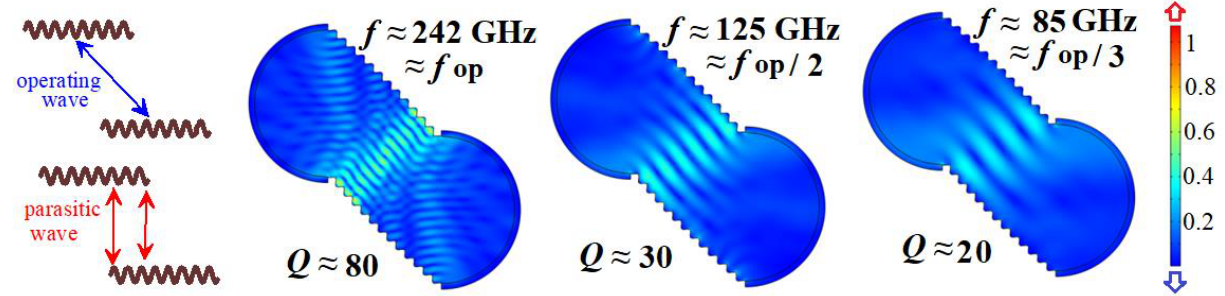
Figure 3. Modes corresponding to ordinary Fabry–Perot resonance near the target frequency, as well as near the 2nd subharmonic and the 3rd subharmonic. The Q-factor is low due to a small overlap of the mode field radiation by the mirrors. The color scale is in arbitrary units.